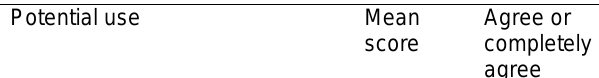
Table 2. Perceived usefulness in different aspects. Responses scored on a scale of 1-5, where one is most positive (completely